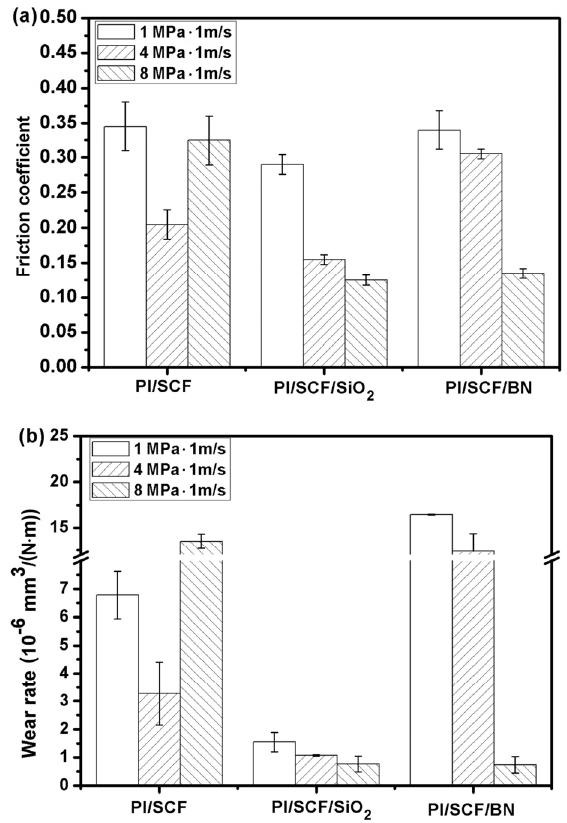
Fig. 10 (a) Average friction coefficients and (b) wear rates of PI/SCF, PI/SCF/SiO 2 , and PI/SCF/BN after sliding against Al 2 O 3 at 1, 4, and 8 MPa·1m/s.